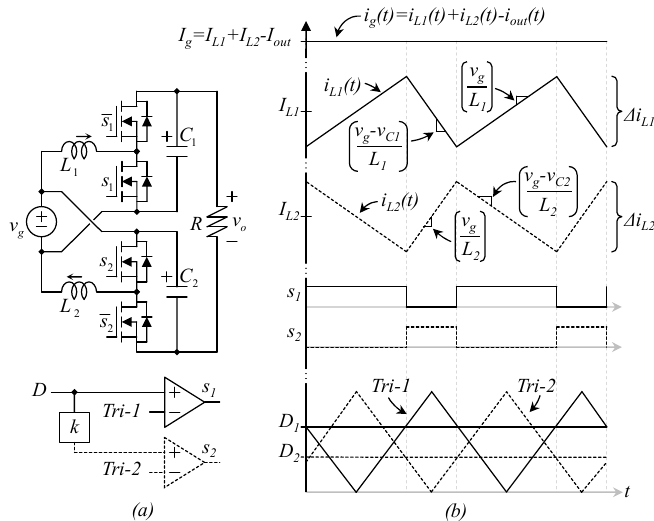
Figure 8. The DDBC during the zero-input current-ripple, with the PWM strategy studied in [4] ( a ) PWM block diagram, and the circuit schematic, and ( b ) important waveforms of the PWM strategy and the circuit operation.